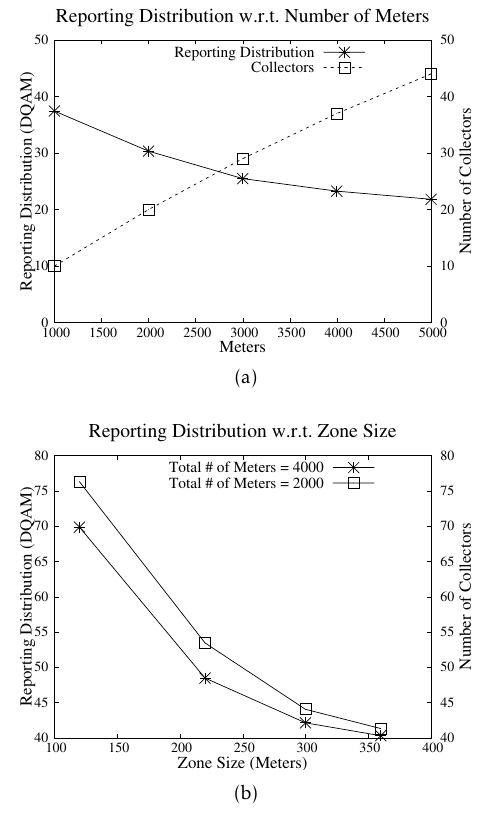
Figure 3. The impact of number of meters on the reporting schedule at (a) the collector level and (b) the meter